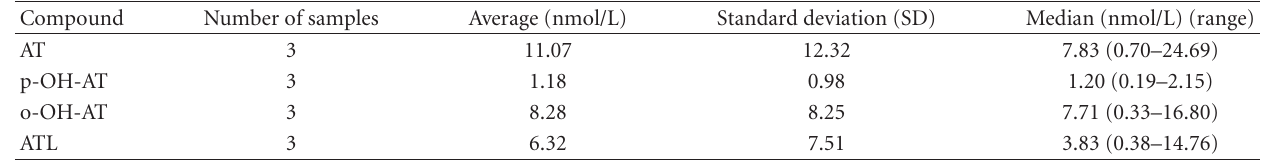
Table 3: Atorvastatin and its metabolites in the matrix